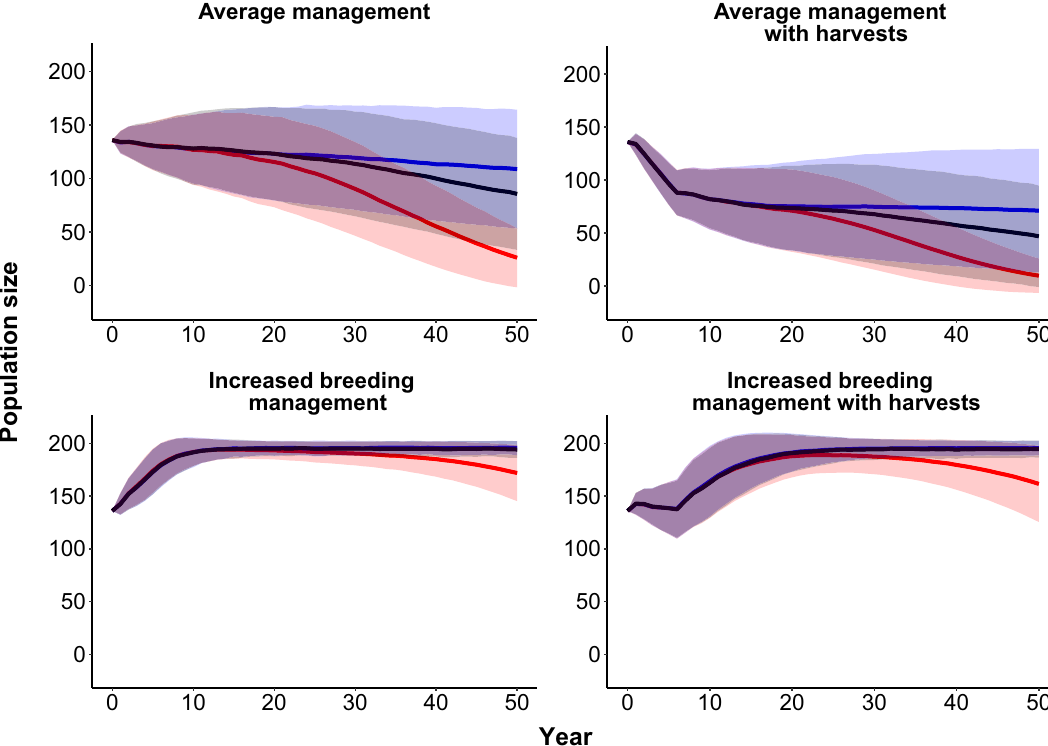
Figure 3. Simulated size of the sihek ex-situ population under alternative management scenarios. Solid lines indicate mean population size across model iterations, with standard deviation (shaded areas). Colours indicate model scenarios including our sihek B estimates (red), no inbreeding depression (blue), or default B